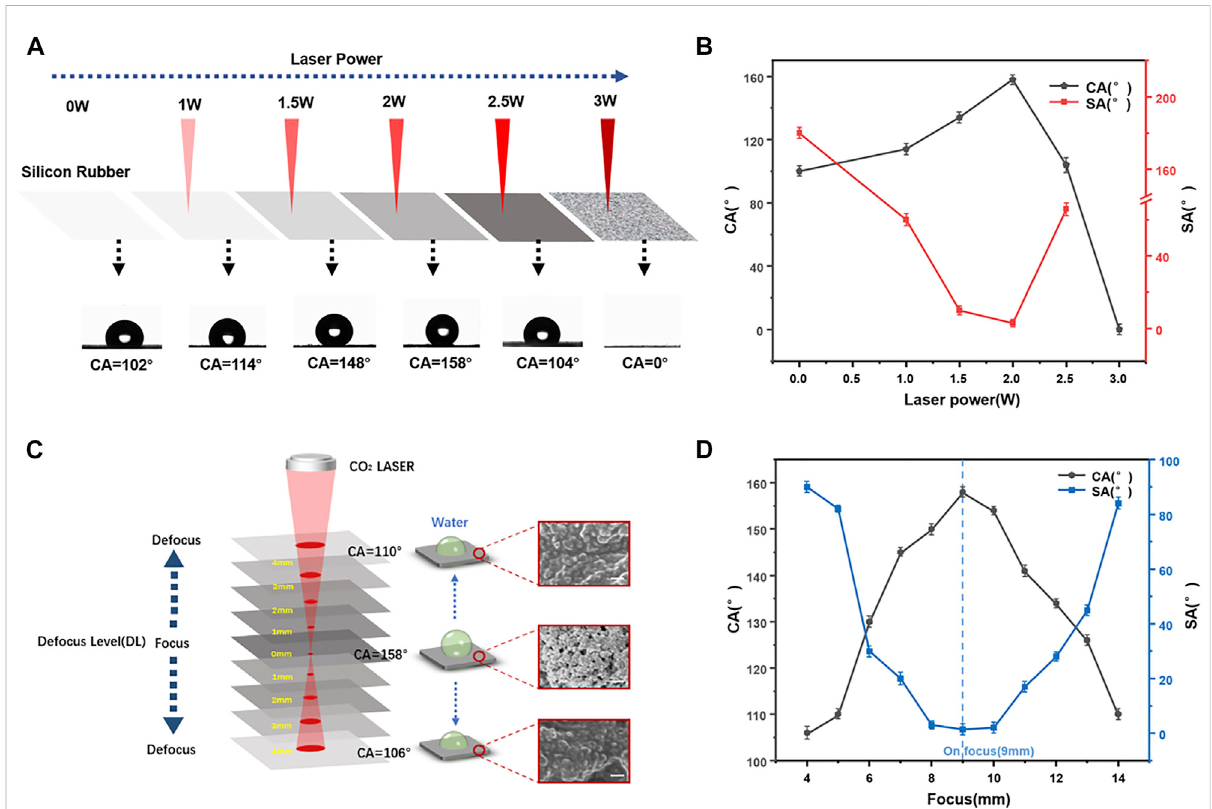
FIGURE 2 (A,B) Continuous regulation of silicone rubber surface wettability by controlling laser power. (C,D) Continuous regulation of silicone rubber surface wettability by adjusting the defocus level (DL). (Scale bar, 400